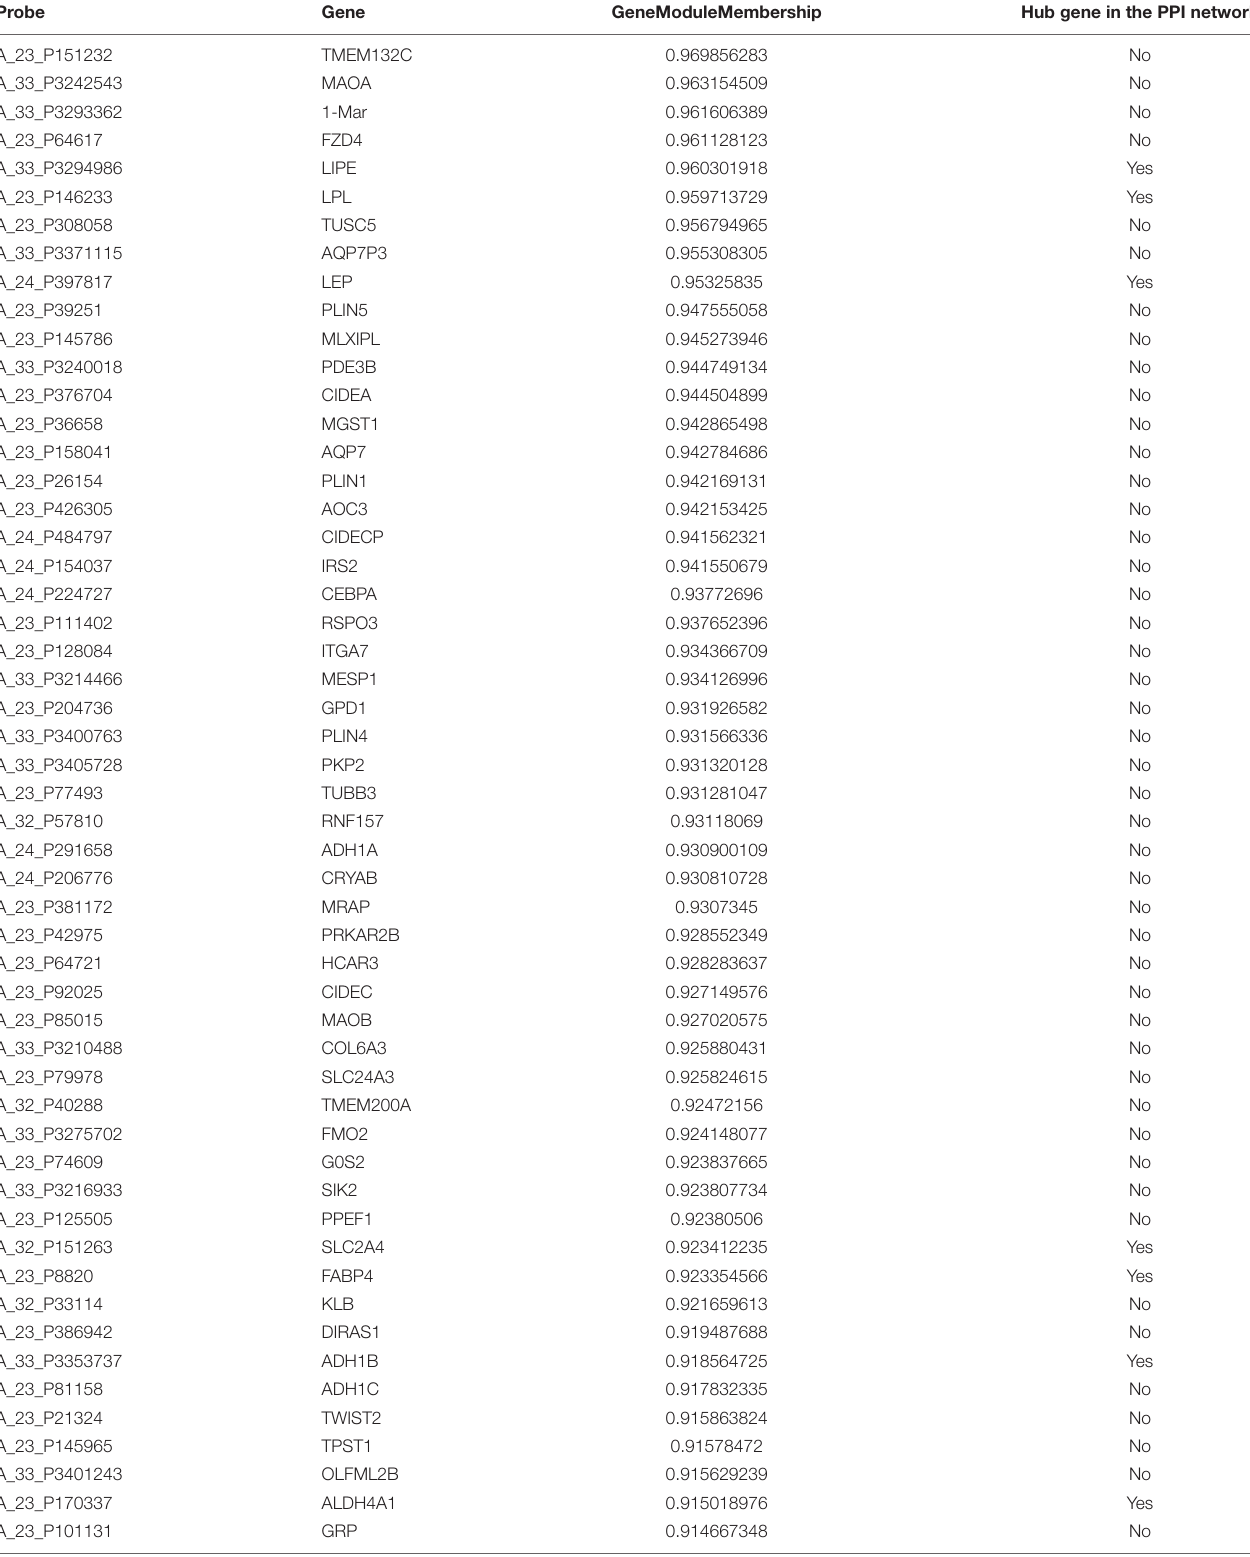
TABLE 2 | Hub genes from the brown module. Probe Gene Hub gene in the PPI